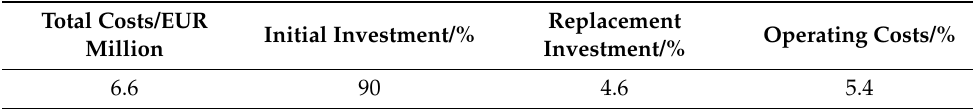
Table 15. Results of the planning variant with BSS.